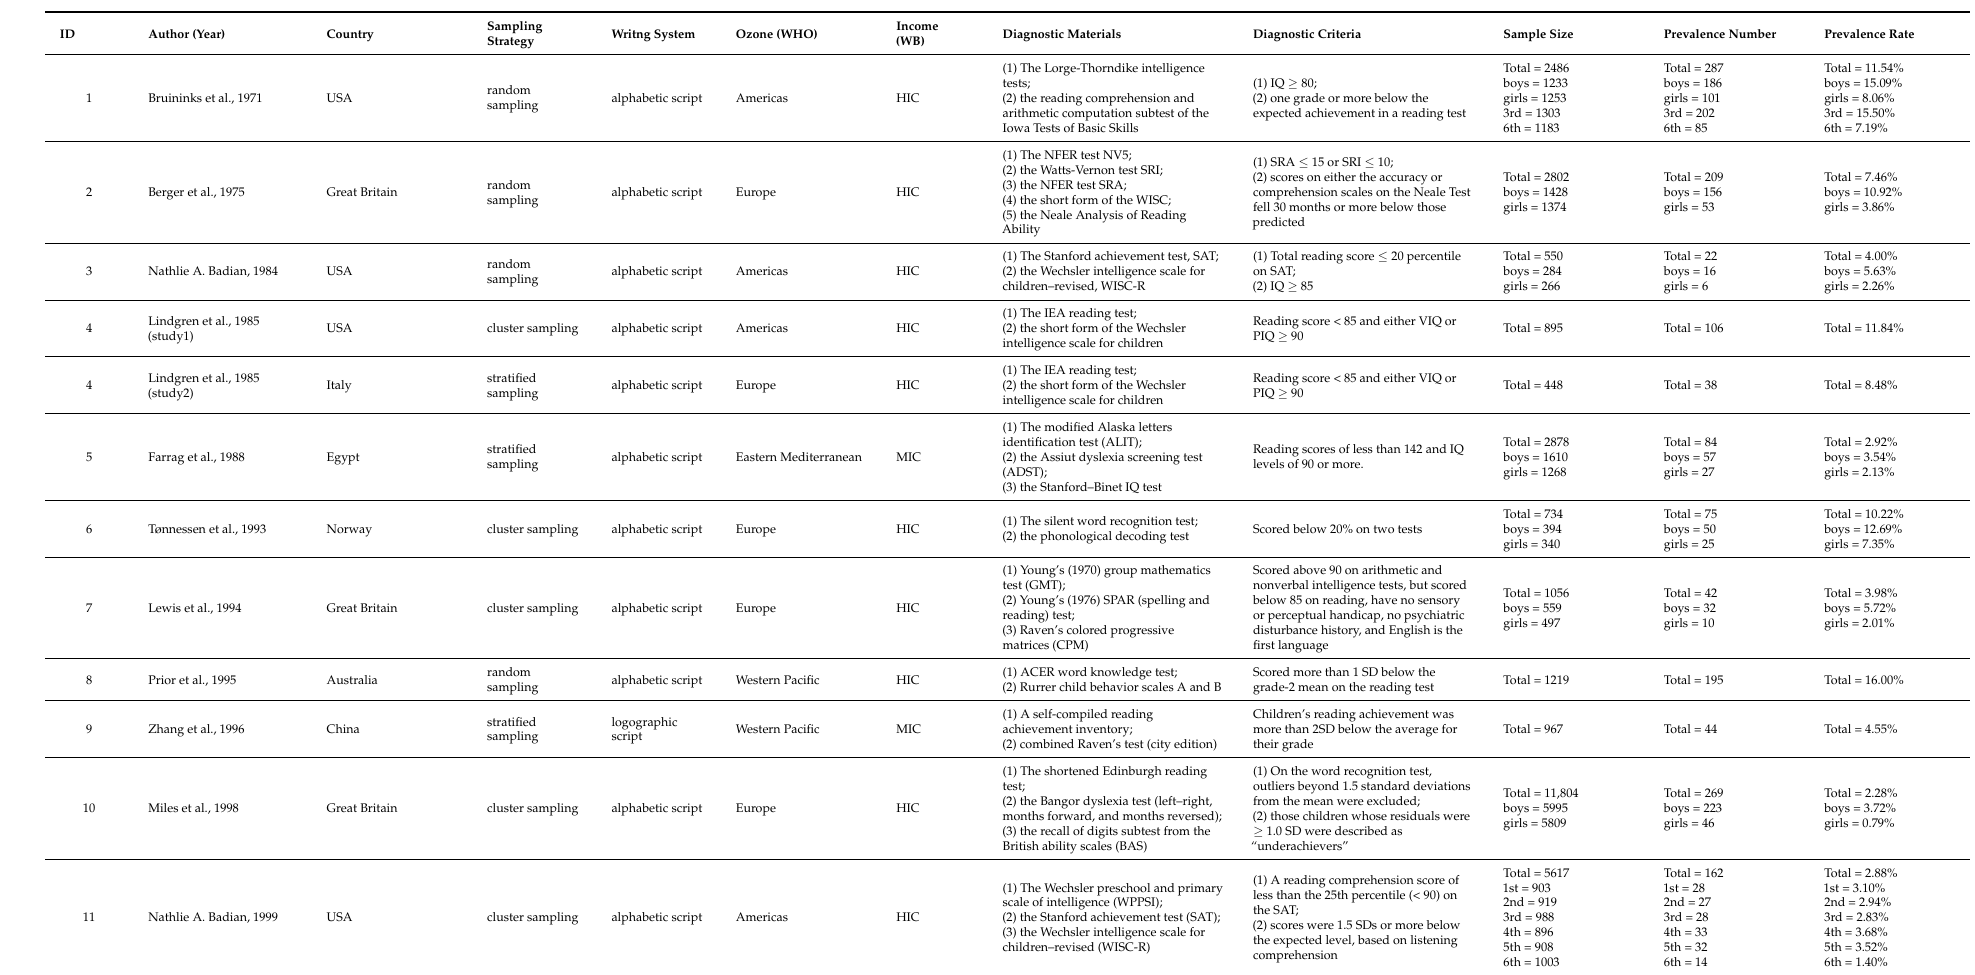
Table A3. Characteristics of included